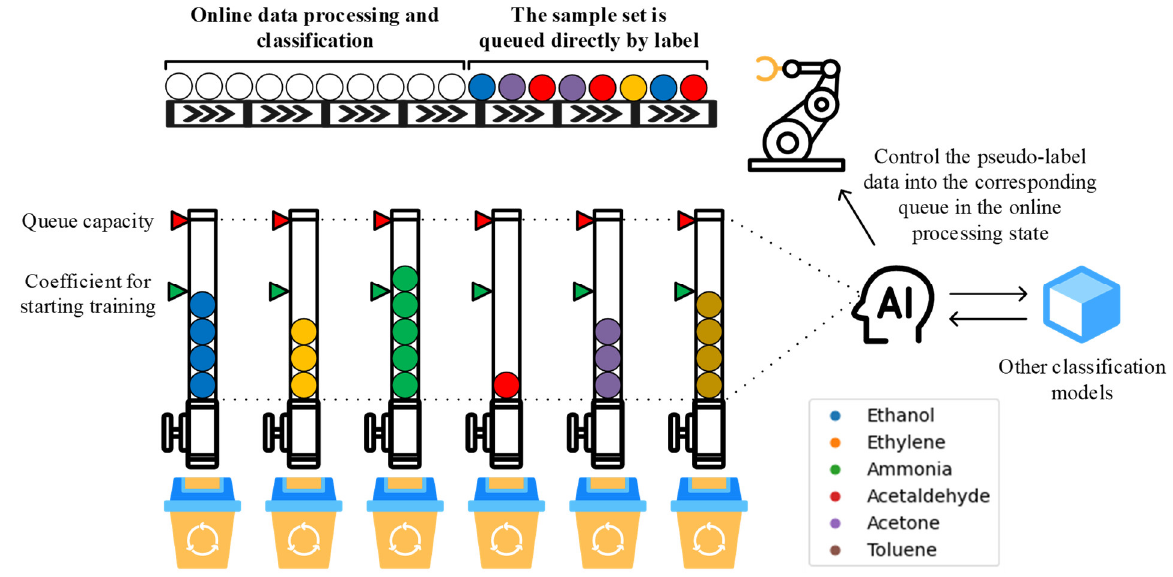
Figure 2. The operating mechanism and workflow of the online inertial learning framework.